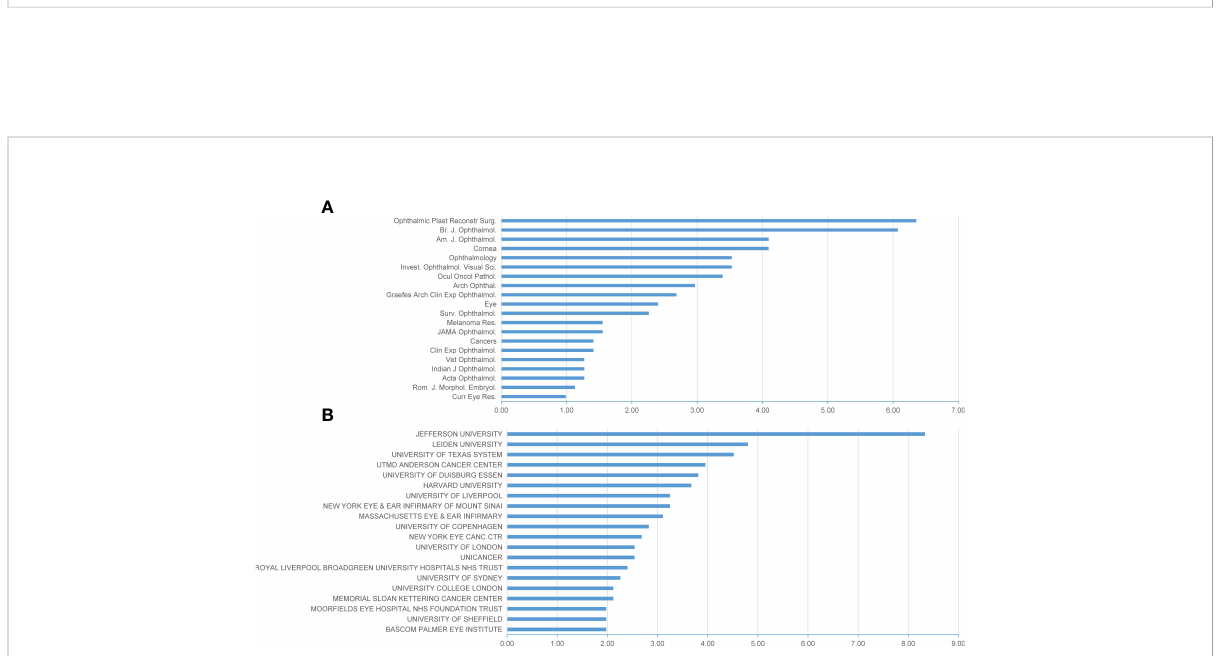
FIGURE 4 Distribution of journals and institutions focusing on CM. (A) Top 20 journals publishing the most papers in this fi eld; (B) top 20 institutions publishing the most papers in this fi